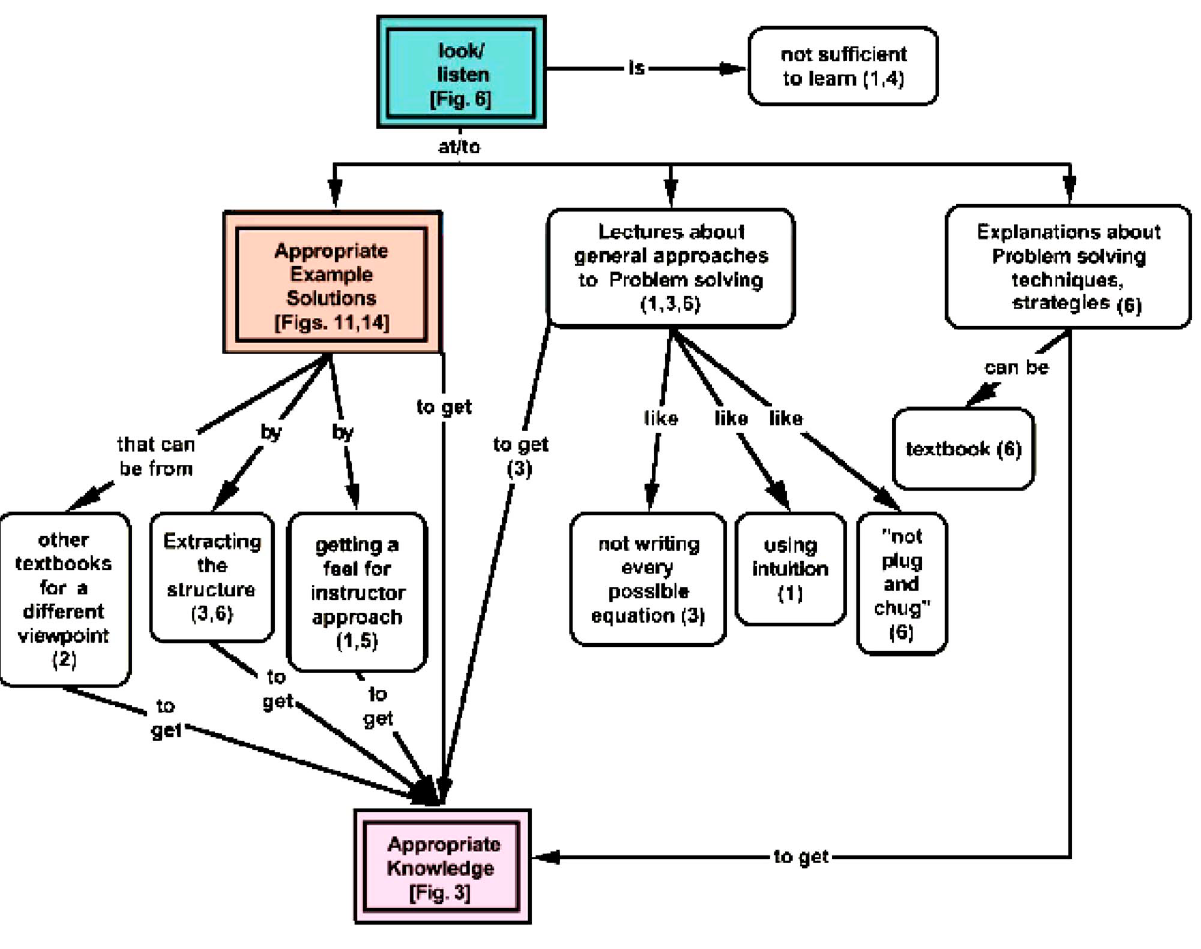
FIG. 6. (cid:1) Color (cid:2) “Look/Listen” composite map of faculty beliefs about learning from looking at or listening to an instructor’s lecture or example problem solution. Numbers in the parentheses denote the instructor whose statements directly justify that category. The boxes framed with a double line indicate principal categories that are elaborated in other composite